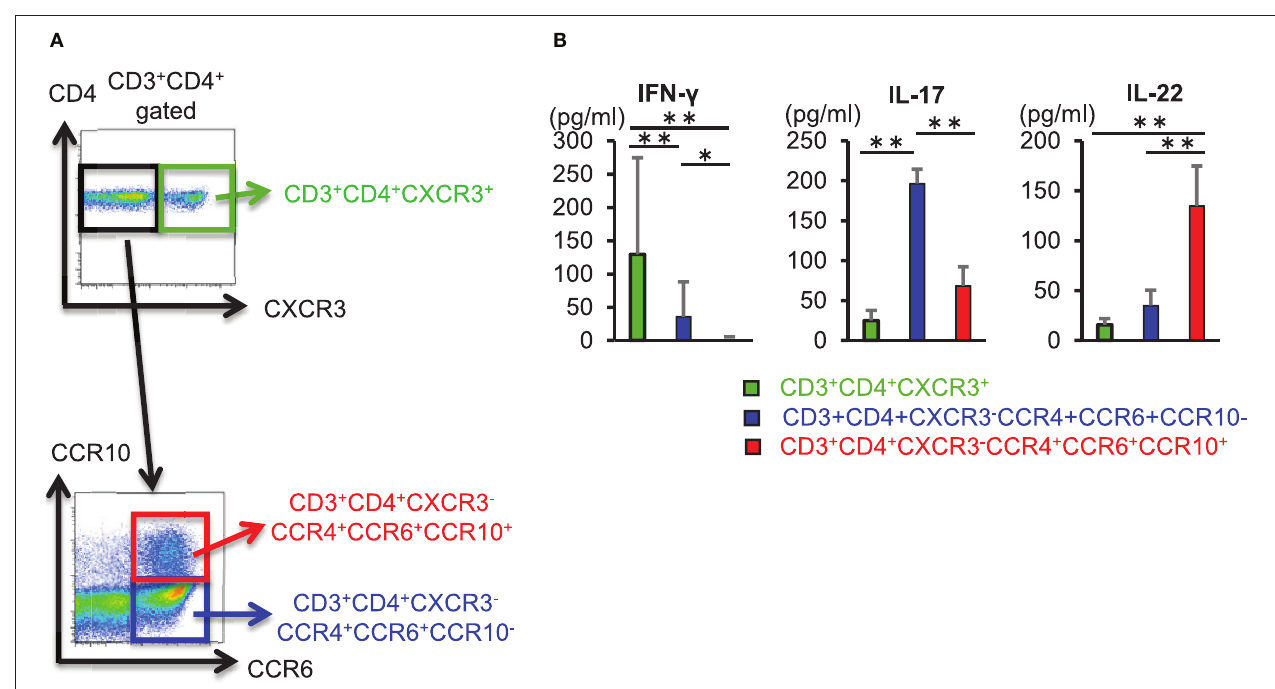
FIGURE 1 | CD3 + CD4 + CCR4 + CCR6 + CCR10 + Th22 cells produce IL-22. (A) Cell-sorting strategy for helper T cells. Among CD3 + CD4 + cells, CXCR3 + ( top ), CXCR3 − CCR4 + CCR6 + CCR10 − , and CXCR3 − CCR4 + CCR6 + CCR10 + cells ( bottom ) were sorted. (B) Cytokine levels in supernatant from sorted helper T cells stimulated with anti-CD3 and -CD28 antibodies for 3 days. Data are representative of five independent experiments. All data represent the mean ± standard deviation. * p < 0.05 and ** p < 0.01 according to the Bonferroni